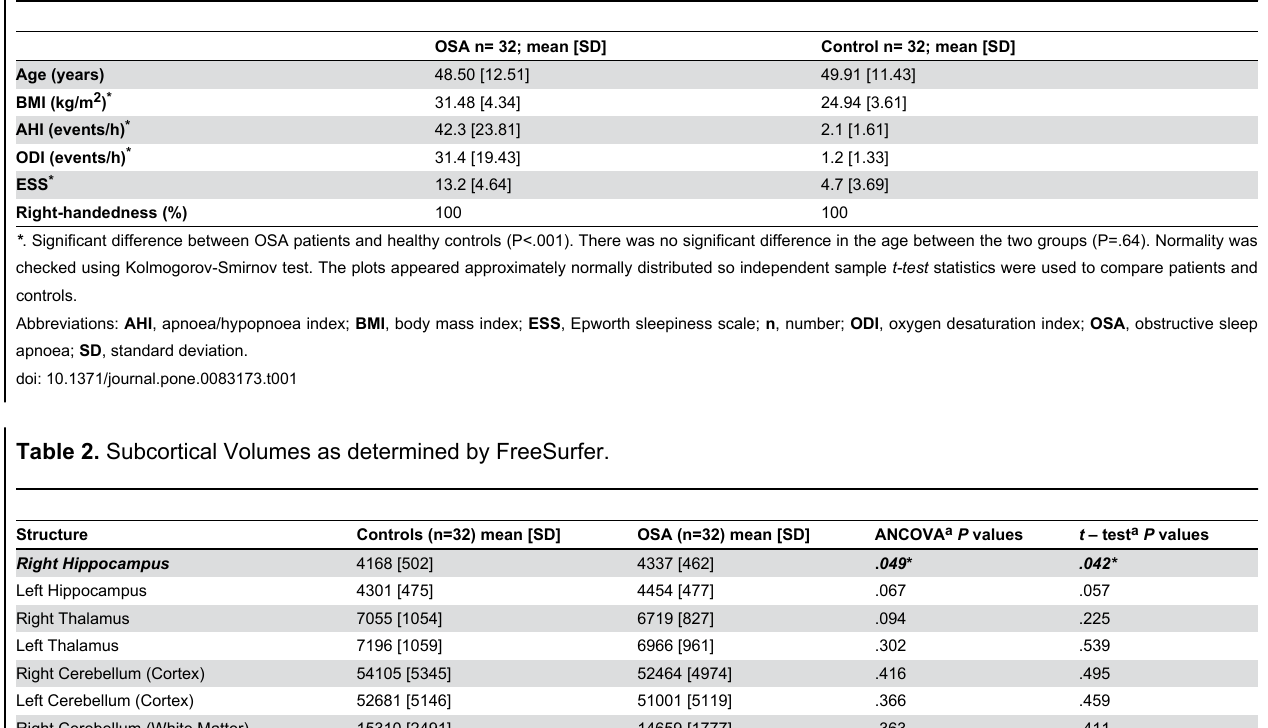
In the table, for each neuroanatomical structure statistical analysis of group differences for volumes normalised to the ICV was performed; t-test and ANCOVA test (covariate with age), were done. Volumes are given as mm 3 .